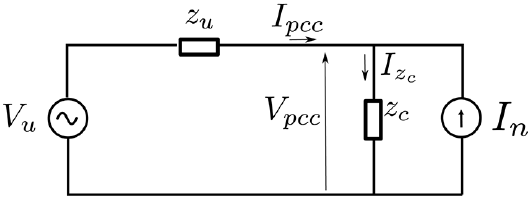
Figure 1. Linear Norton’s equivalent model of the customer side distribution grid.